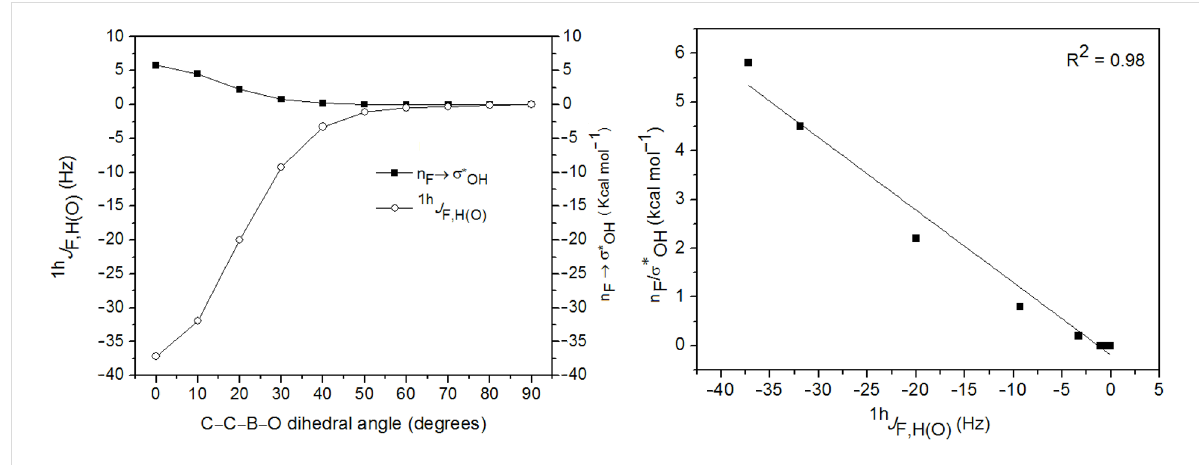
Figure 6: Angular dependence of 1 h J F,H(O) and n F →σ * OH in 1a , obtained at the BHandH/EPR-III ( J ) and B3LYP/aug-cc-pVDZ (n F →σ * OH ) levels.